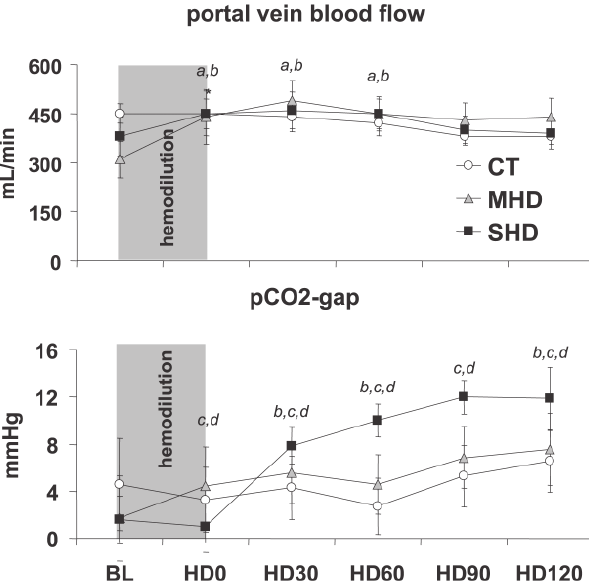
Table 1 - Systemic oxygen delivery, consumption and extraction (DO excess and lactate, in control (CT) moderate and severe hemodilution (MHD and SHD) groups GROUPS BL HD0 HD30 HD120 Systemic DO